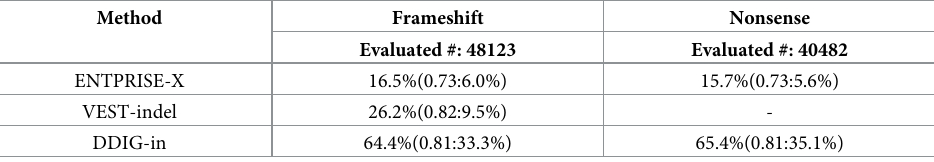
Table 4. Comparison of the percentage of disease causing variations in the ExAC set a